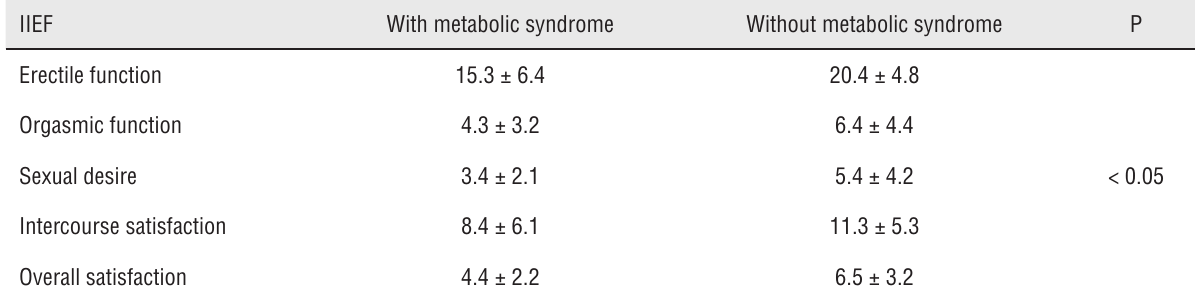
Table 2 - Relationship between the metabolic syndrome and parameters of IIEF questionnaire.